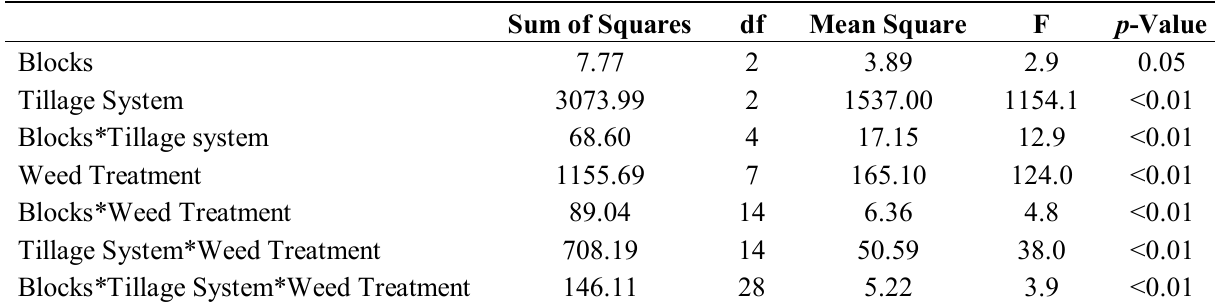
Table 6. Analysis of variance for the split plot